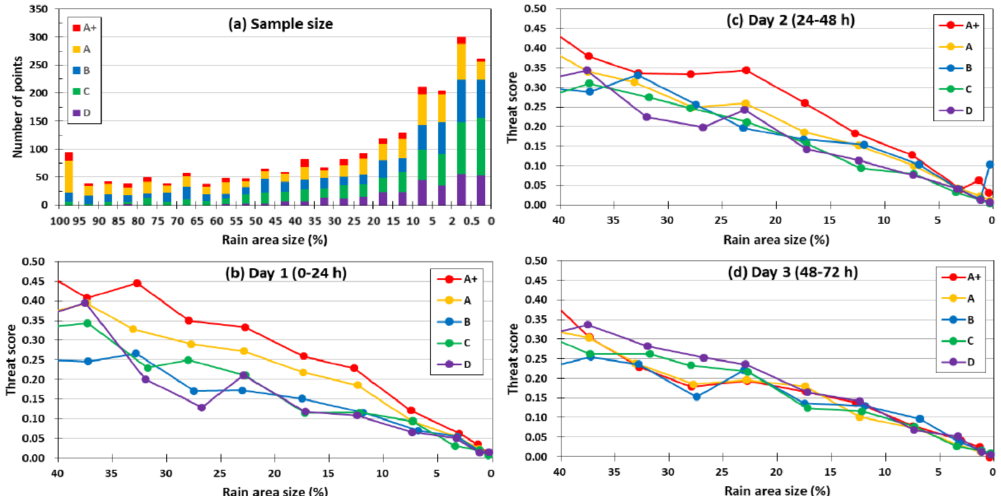
Figure 11. (a) The distribution of data points in the bins of observed rain area size (%; every 5% from 100% to 5%, then 2%–5%, 0.5%– 2%, and < 0 . 5%; same for days 1–3) among groups A + and A to D. (b–d) The TS of 24h QPFs for (b) day 1 to (d) day 3, respectively, as a function of observed rain area size between 40% and